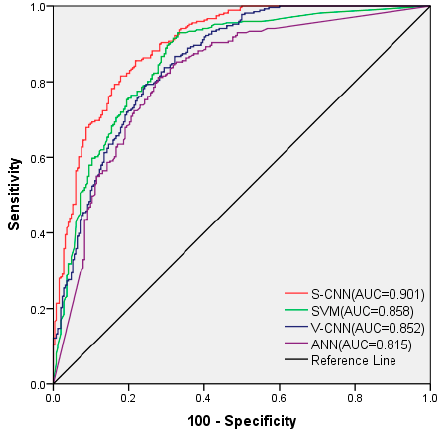
Figure 16. The ROC curves and AUC values of the four models on the validation set.